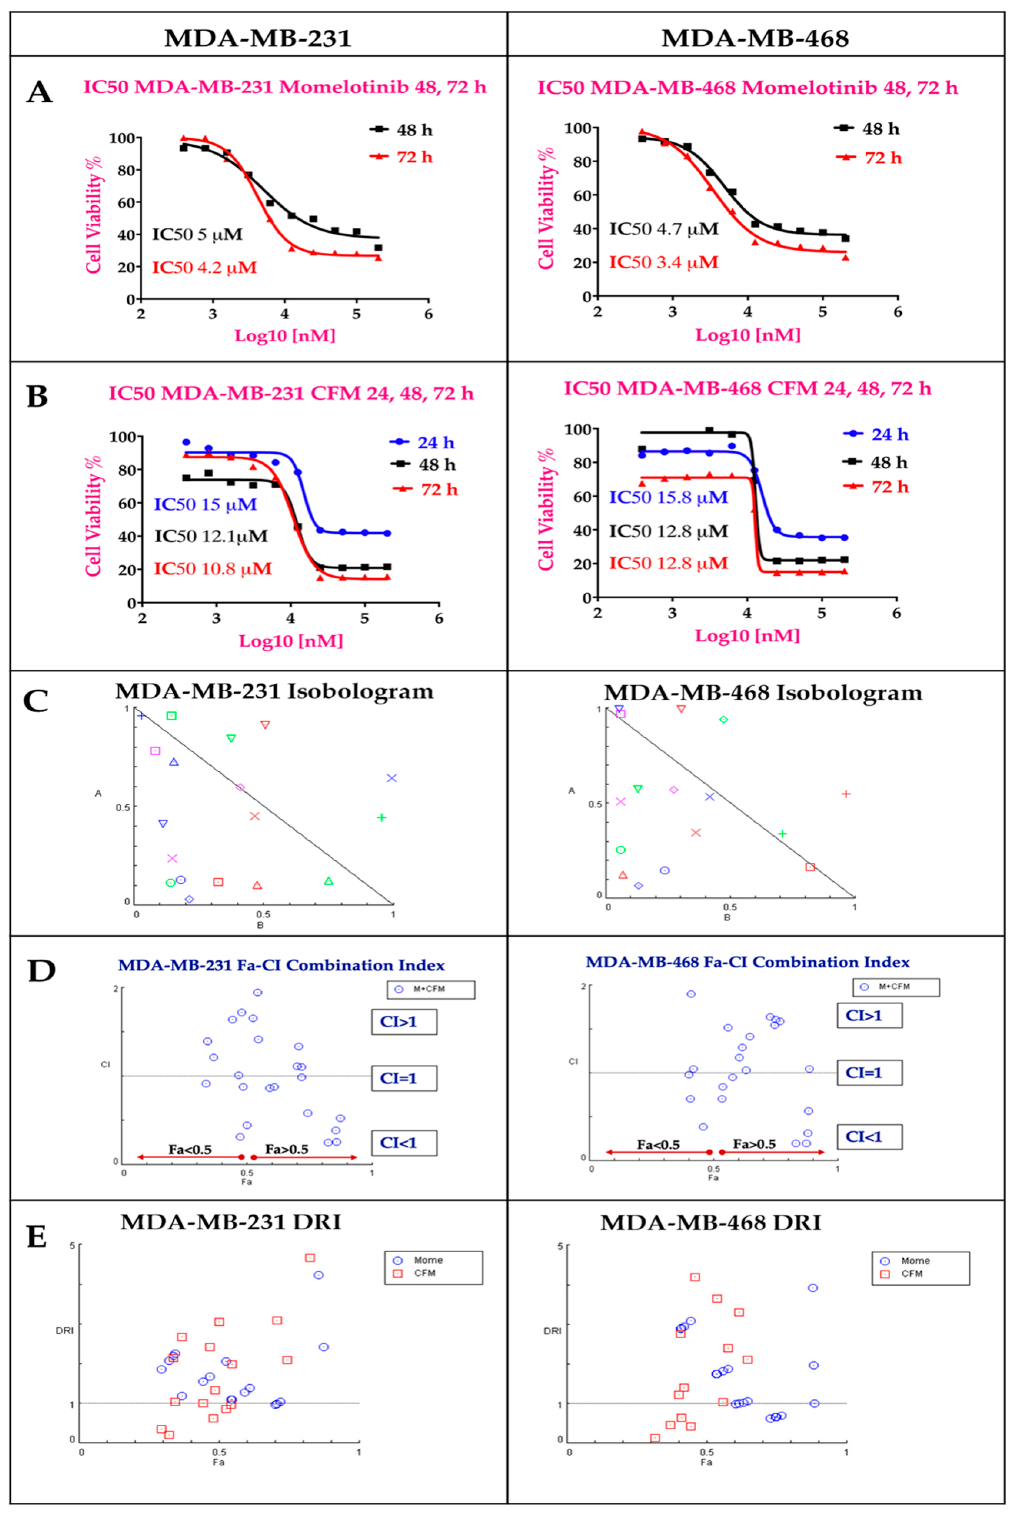
Figure 2. The individual MMB and CFM-4.16 cytotoxicity, Isobologram, Fa-CI index, and Dose Reduction Index (DRI) for the combination of MMB and CFM-4.16 in both MDA-MB-231 and MDA-MB-468 analyzed by COMPUSYN software. ( A ) MMB dose-response curve at 24, 48, 72 h and ( B ) CFM-4.16 dose response curve at 24, 48, 72 h In Isobologram ( C ) the CI < 1, CI = 1, and CI > 1 indicate synergism, additivity, and antagonism, respectively. ( D ) The Fa-CI index of MMB + CFM-4.16 combination at which the synergistic points have CI < 1 with Fa > 0.5. In the DRI ( E ), DRI < 1, DRI = 1, and DRI > 1 indicate unfavorable dose reduction, no dose reduction and favorable dose reduction. Note: MMB means momelotinib.